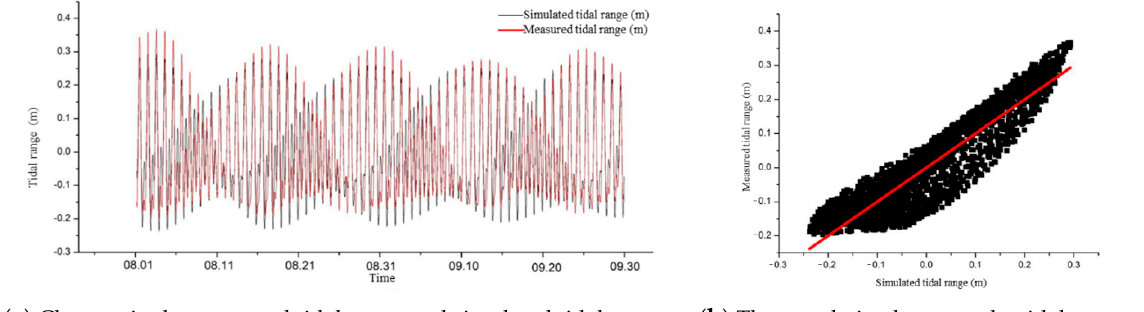
Figure 5. Changes in ( a ) and correlation between ( b ) the measured tidal range and simulated tidal range over time at 118.93° E, 38.08° N (Pearson’s r = 0.92).